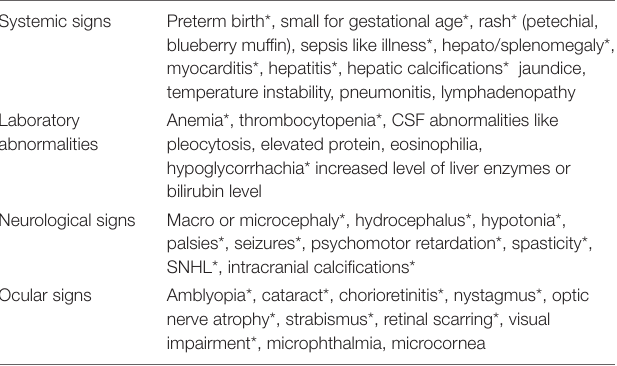
TABLE 1 | Clinical features reported to be associated with congenital toxoplasmosis (14, 21,